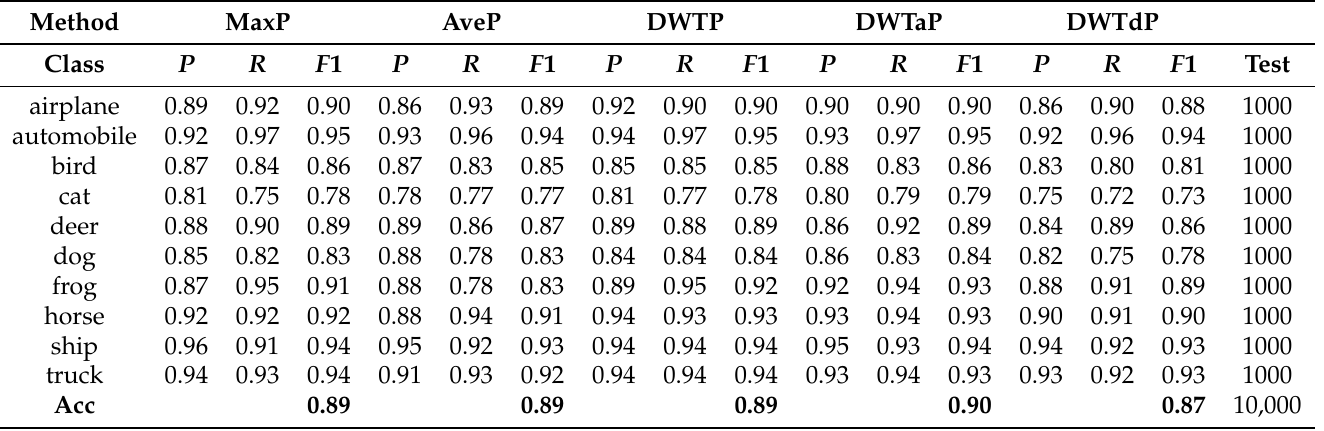
Table A1. Classification report for CIFAR-10 dataset. In this case, each pooling method is evaluated considering DropOut, Data Augmentation, and Batch